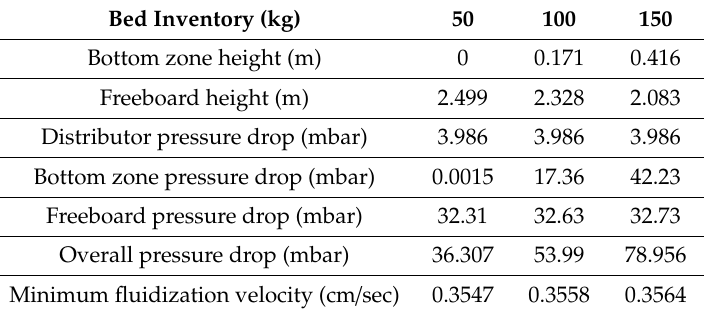
Table 5. Bed parameters for the three mass inventories 50, 100, and 150